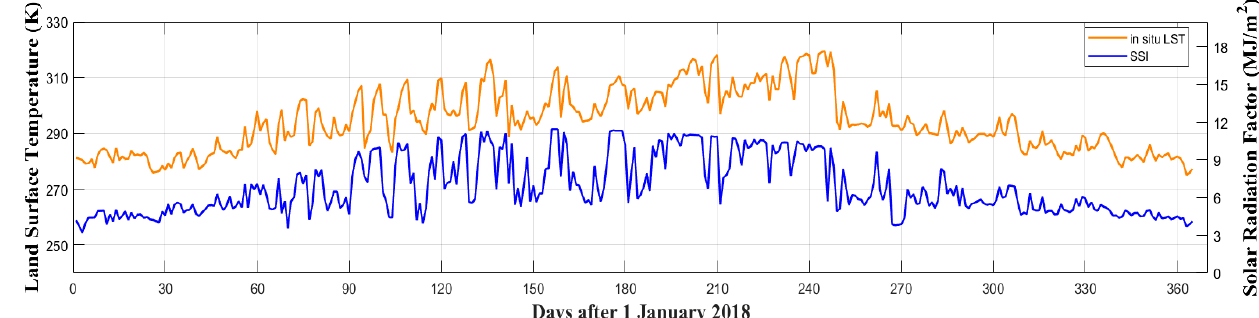
Figure 11. The in situ LST and estimated solar radiation factor over the CS site and their change with the day of the year.